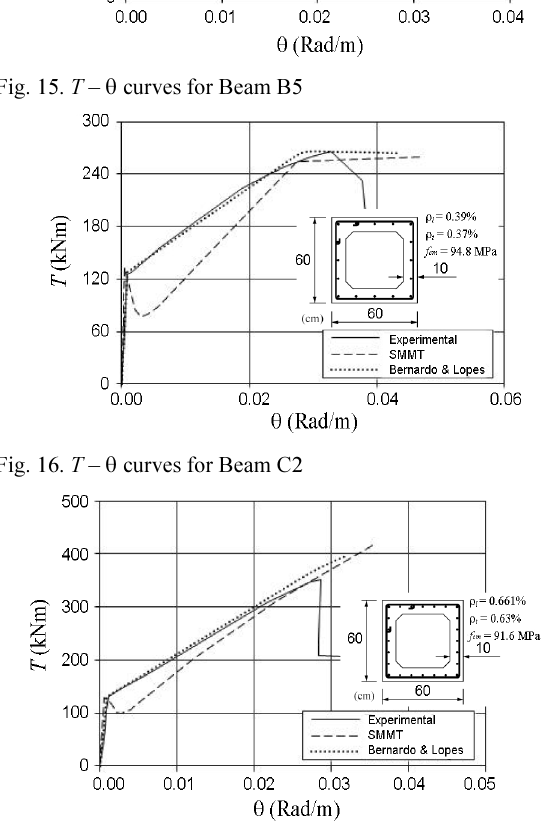
Fig. 13. T – θ curves for Beam B3